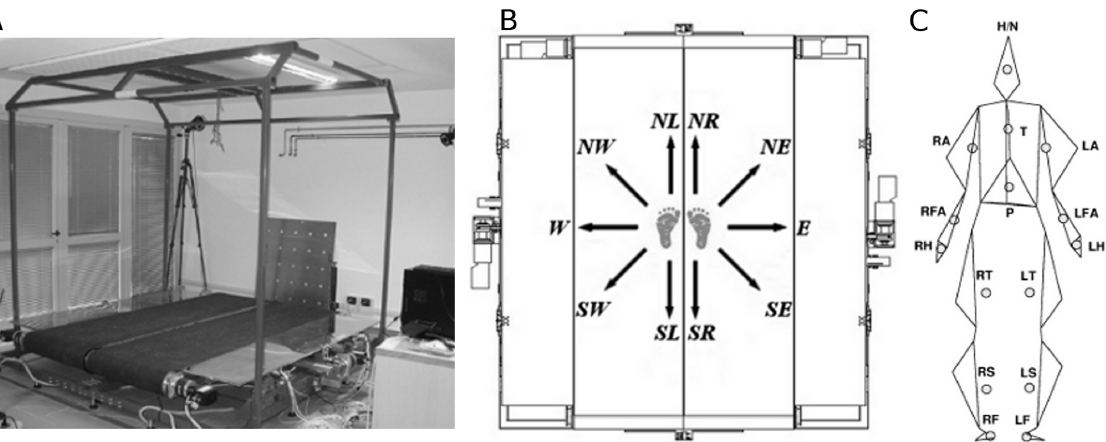
Figure 1. Experimental setup. The subplot A consists of a picture of the SENLY platform. The subplot B represents the 10 types of perturbations. Each perturbation involved the combination of longitudinal (i.e., North, N or South, S ) and transversal (i.e., East, E , or West, W ) movements of the belt provided while participants were walking steadily. Five perturbations were delivered on the left foot (i.e., NL , NW , W , SW , SL ) and five on the right foot (i.e., NR , NE , E , SE , SR ). The subplot C shows an example of the reconstruction of the biomechanical model of a representative subject. The vertexes of each polygon and the dots represent respectively the markers position and the CoM of each body segment with the corresponding acronyms.